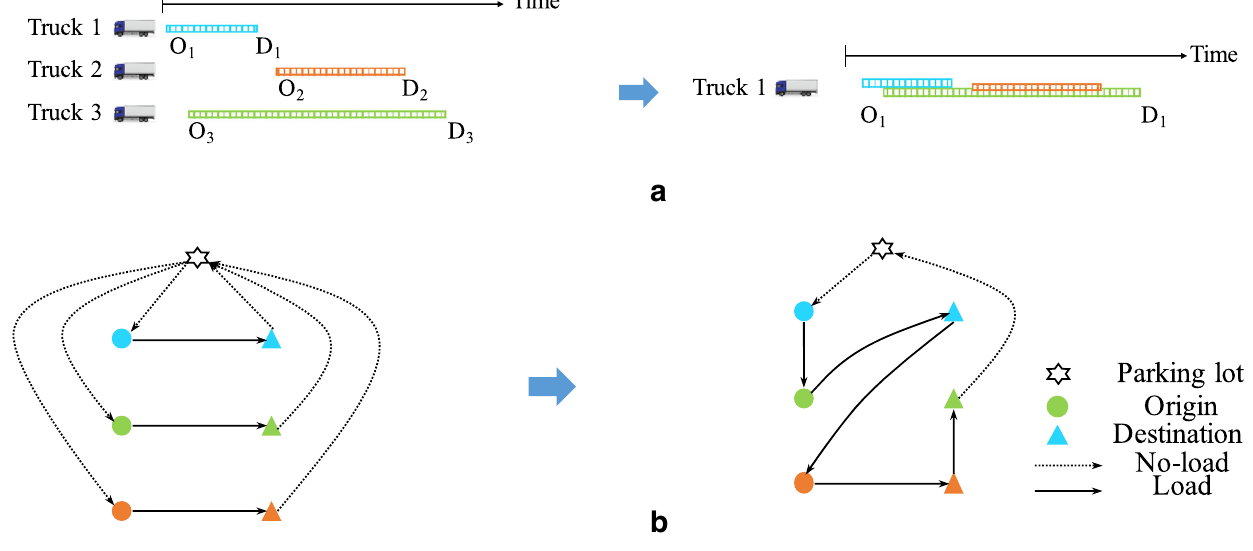
Fig. 7 Optimization technology of route planning for delivery